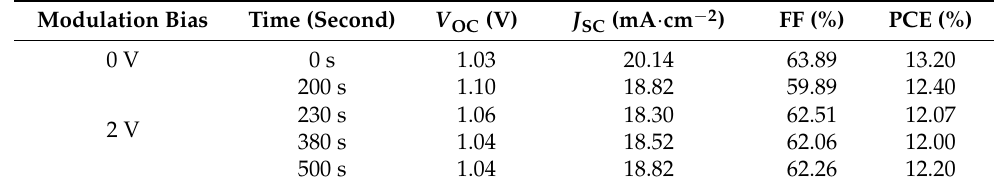
Table 2. Photovoltaic parameters of electric field-modulated quasi-2D perovskite solar cells under different modulation times, at a constant forward bias with the same batch of devices.